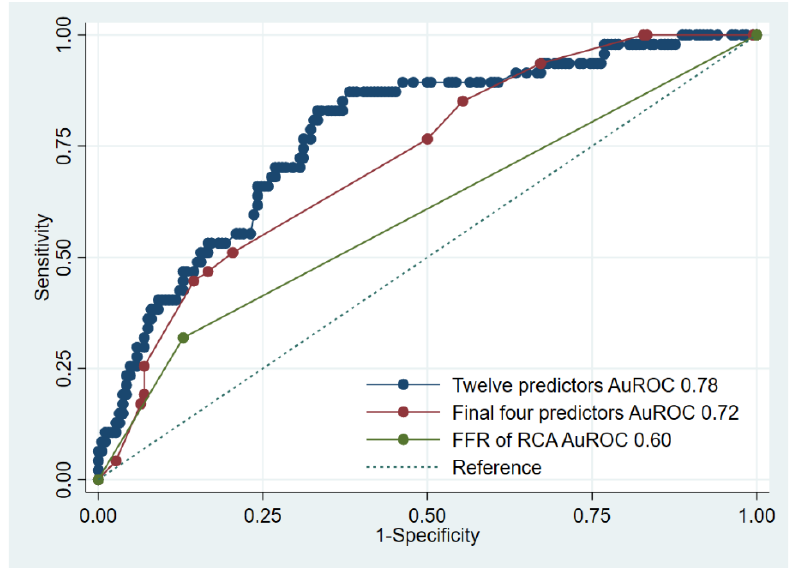
Figure 4. Comparison of area under receiver operating characteristic curve (AuROC) between all 12 predictors, final 4 predictors, and only single predictor (FFR procedure of RCA) in predicting the occurrence of FFR ≤ 0.8 at adenosine 150, 200 mcg. FFR—fractional flow reserve; RCA—right coronary artery.